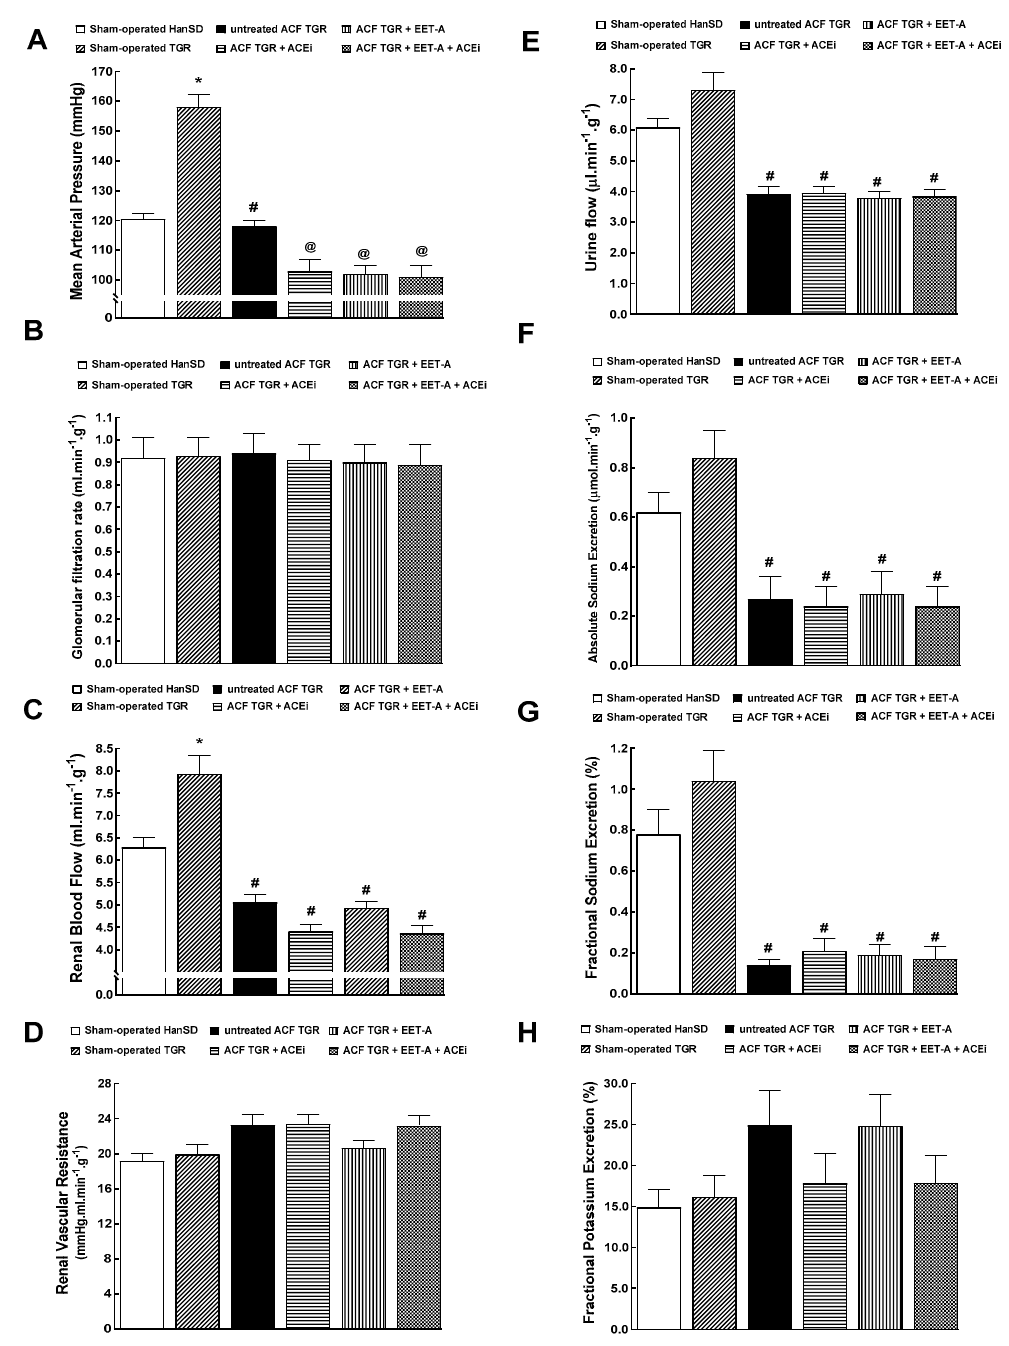
Figure 6. Renal function analysis was performed 4 weeks after the creation of the aorto-caval fistula (ACF) and 2 weeks after initiation of treatment in sham-operated transgene-negative Hannover Sprague-Dawley (HanSD), sham-operated heterozygous Ren-2 transgenic rats (TGR), and TGR rats with ACF, untreated or treated with angiotensin-converting enzyme inhibitor (ACEi) alone or with 14,15-epoxyeicosatrienoic acid analog (EET-A) alone or with the combination of EET-A and ACEi. Mean arterial pressure ( A ), glomerular filtration rate ( B ), renal blood flow ( C ), renal vascular resistance ( D ), urine flow ( E ), absolute ( F ) and fractional sodium excretion ( G ) and fractional potassium excretion ( H ) * p < 0.05 for sham-operated TGR versus sham-operated HanSD rats. # p < 0.05 versus sham-operated TGR. @ p < 0.05 versus untreated ACF